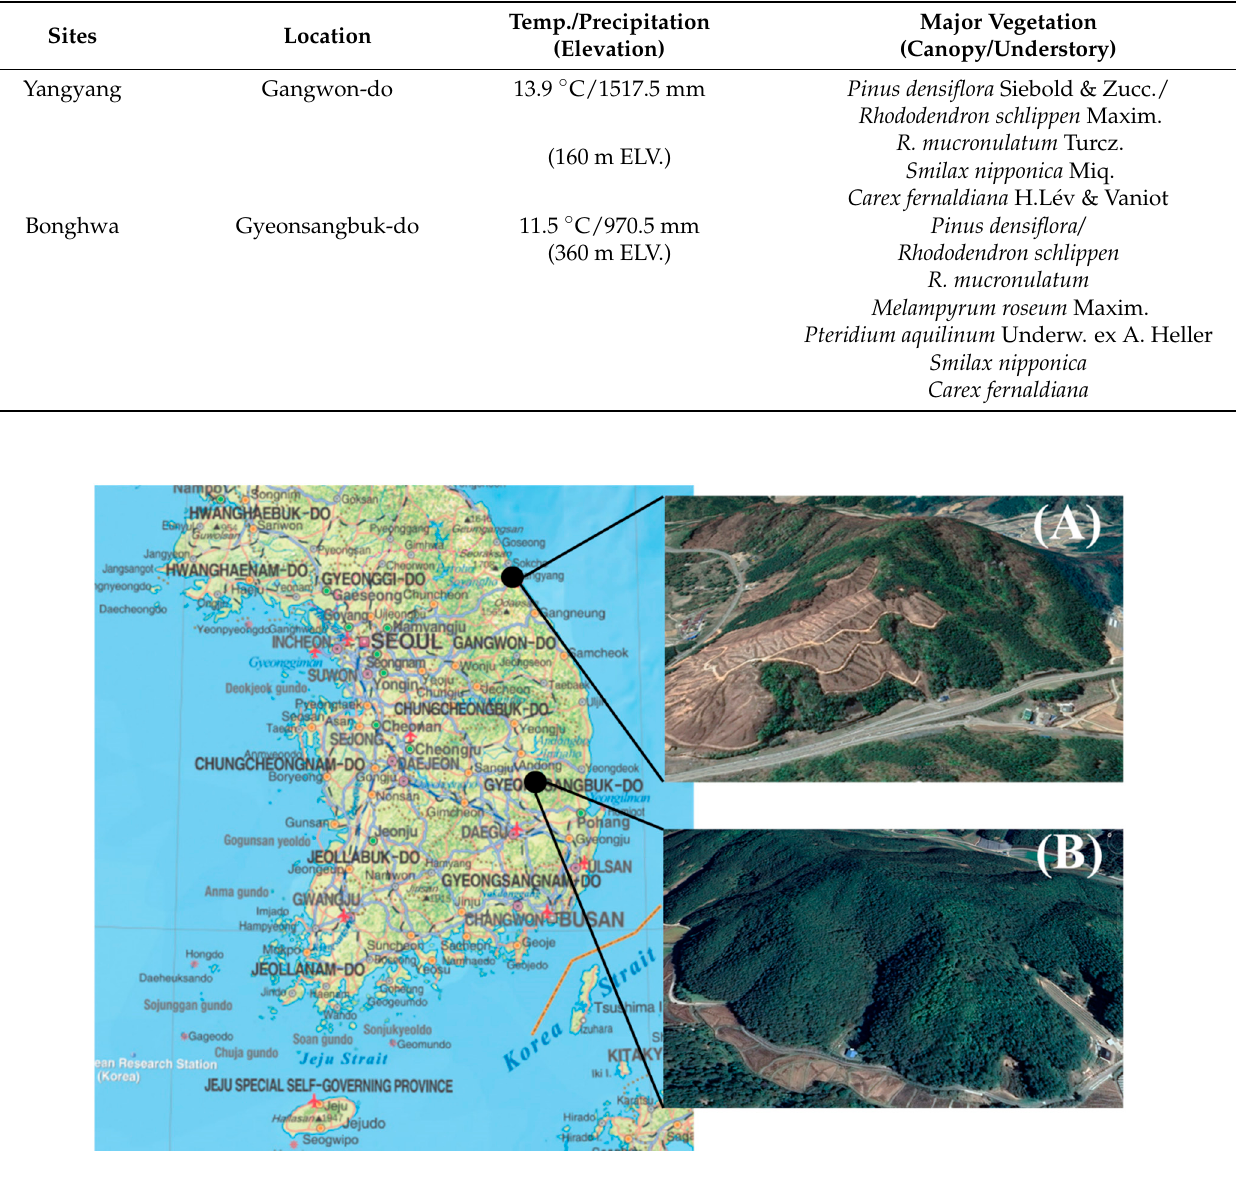
Figure 1. Sampling sites were located in Yangyang-gun, Gangwon-do ( A ), and Bonghwa-gun, Gyeongsangbuk-do ( B ) in Korea. The map was downloaded from National Geographic Information Institute (NGII, https://www.ngii.go.kr/ (accessed on 11 June